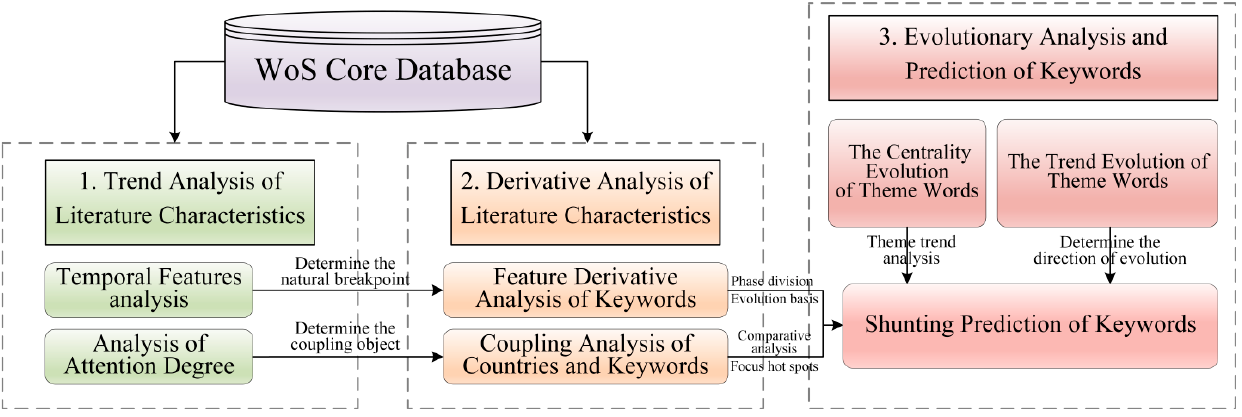
Figure 1. Evolution Mechanism and Prediction Model.